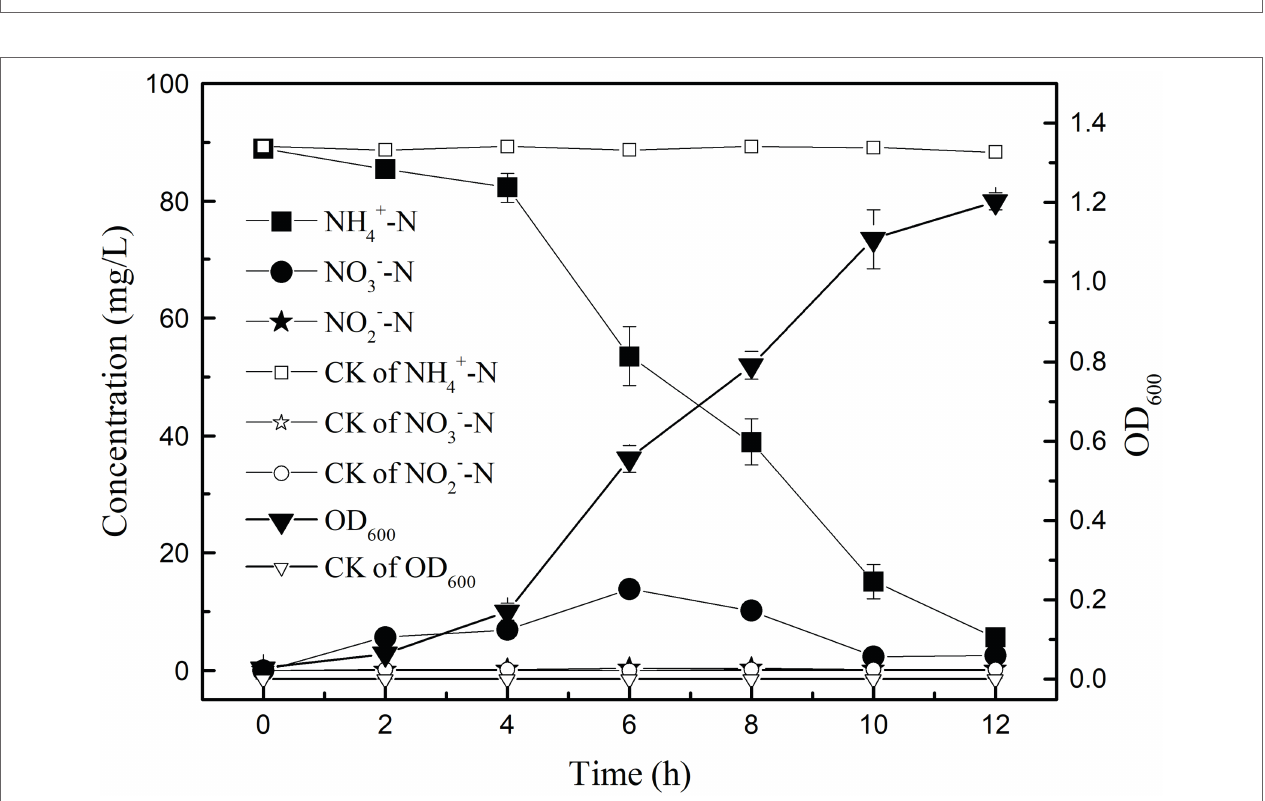
FIGURE 2 | The phylogenetic tree of strain K17. According to the comparison result of GenBank database, it was constructed by neighbour-joining method using MEGA6.0 software.